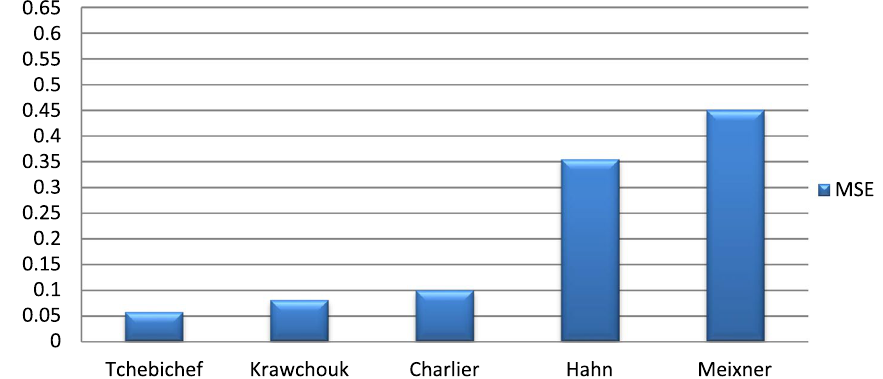
Fig. 7 The average MSE of the reconstructed signals using Tchebichef, Krawtchouk , Charlier, Hahn, and Meixner moment with Householder